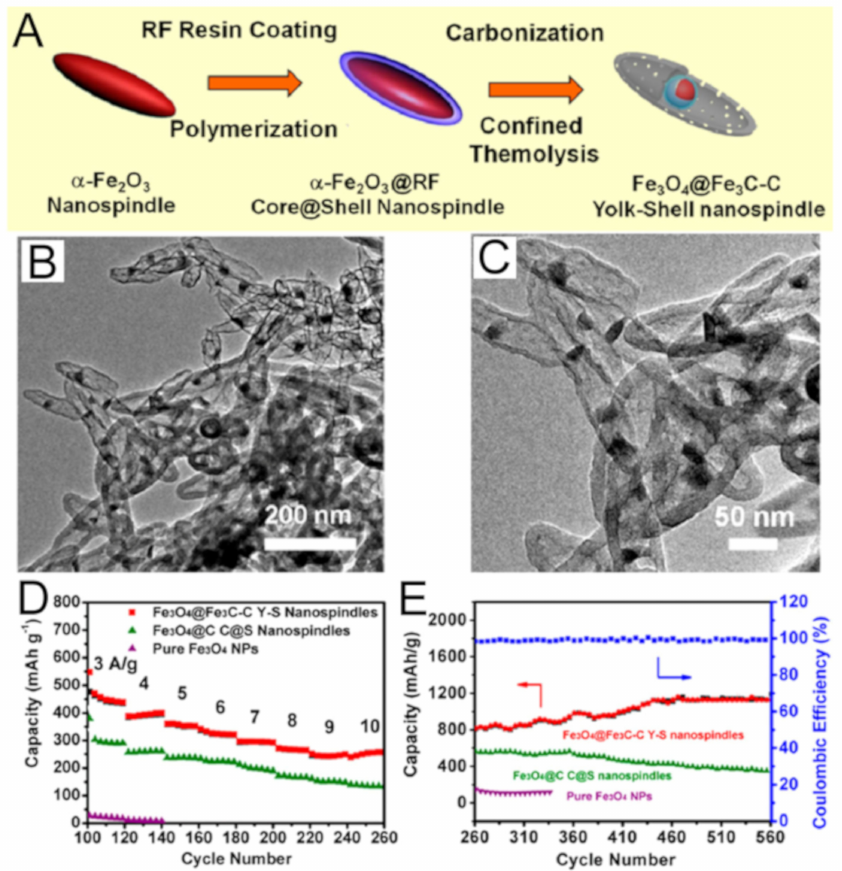
Figure 12. ( A ) Scheme showing the formation of Fe 3 O 4 @Fe 3 C-C yolk–shell nanostructure. ( B,C )